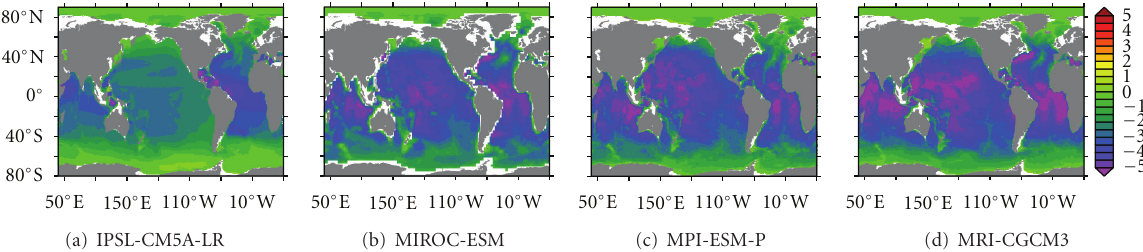
Figure 4: Ocean heat content change ( × 10 10 Jm − 2 ) at the Last Glacial Maximum. Most cooling occurs between 40 ◦ S and 40 ◦ N. All the four models show cooling in the Atlantic. But, cooling in the Pacific and Indian Oceans varies.